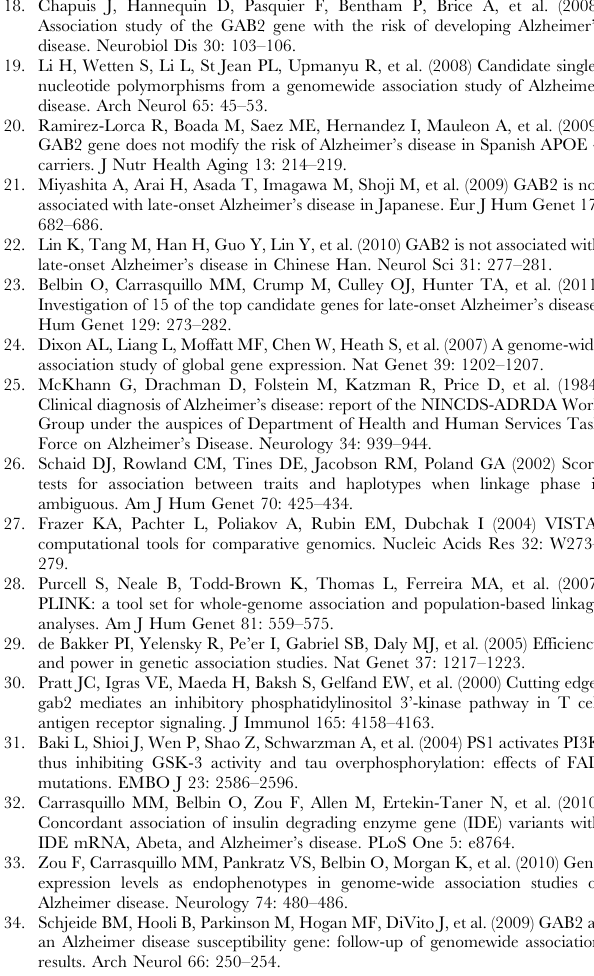
Table S3 GAB2 mRNA levels and postmortem pathol-